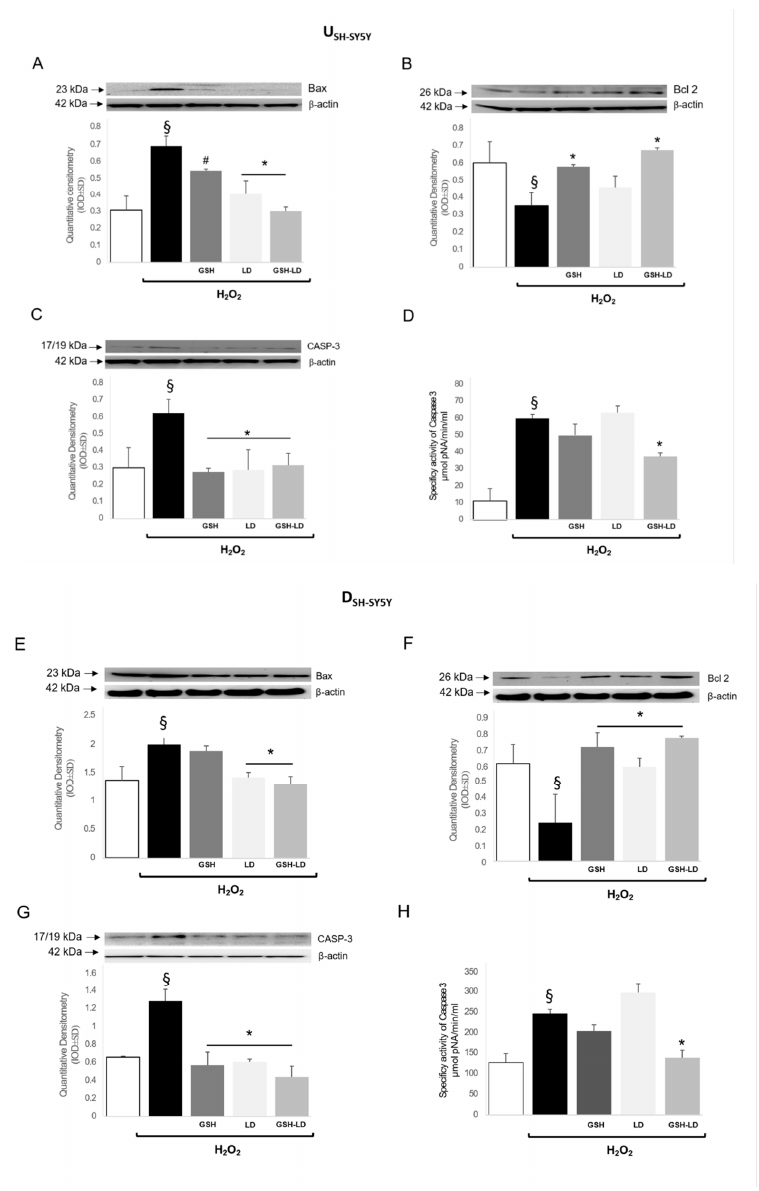
Figure 6. Effects of compounds on expression levels of apoptosis related proteins in the ff ects of compounds on expression levels of apoptosis related proteins in the neuroblastoma neuroblastoma cell line. Effect of GSH, LD and GSH-LD (1 μ M), on the expression levels of Bax ( A,E ) Figure 6. E cell line. E ff ect of GSH, LD and GSH-LD (1 µ M), on the expression levels of Bax ( A , E ) and Bcl-2 ( B , F ) and on caspase 3 expression and fluorescent activity ( C , D , G , H ), on H 2 O 2 -treated U SH-SY5Y